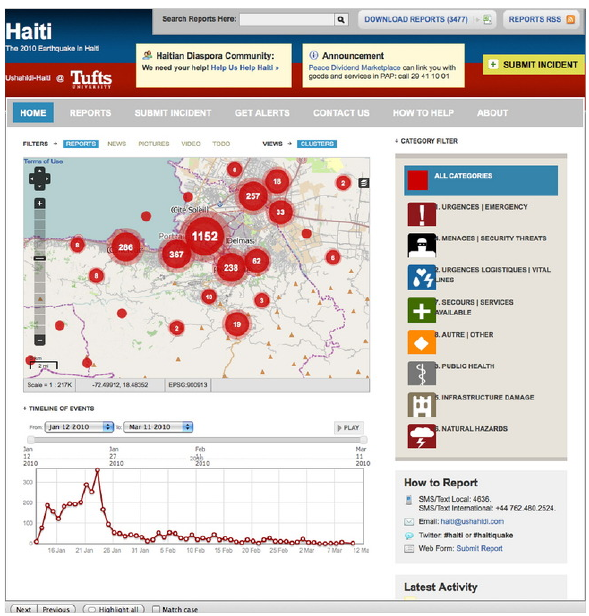
Figure 3. OSM Map of Port-au-Prince 24 hours later